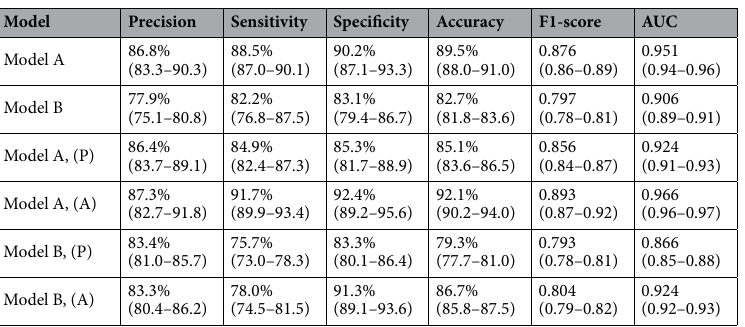
Table 5. Classifications scores of Model A and Model B. Values (except F1-score and AUC) are shown in percentage. The Confidence level was set to 95%. (P) = Pediatric patients only, (A) = Adult patients only.